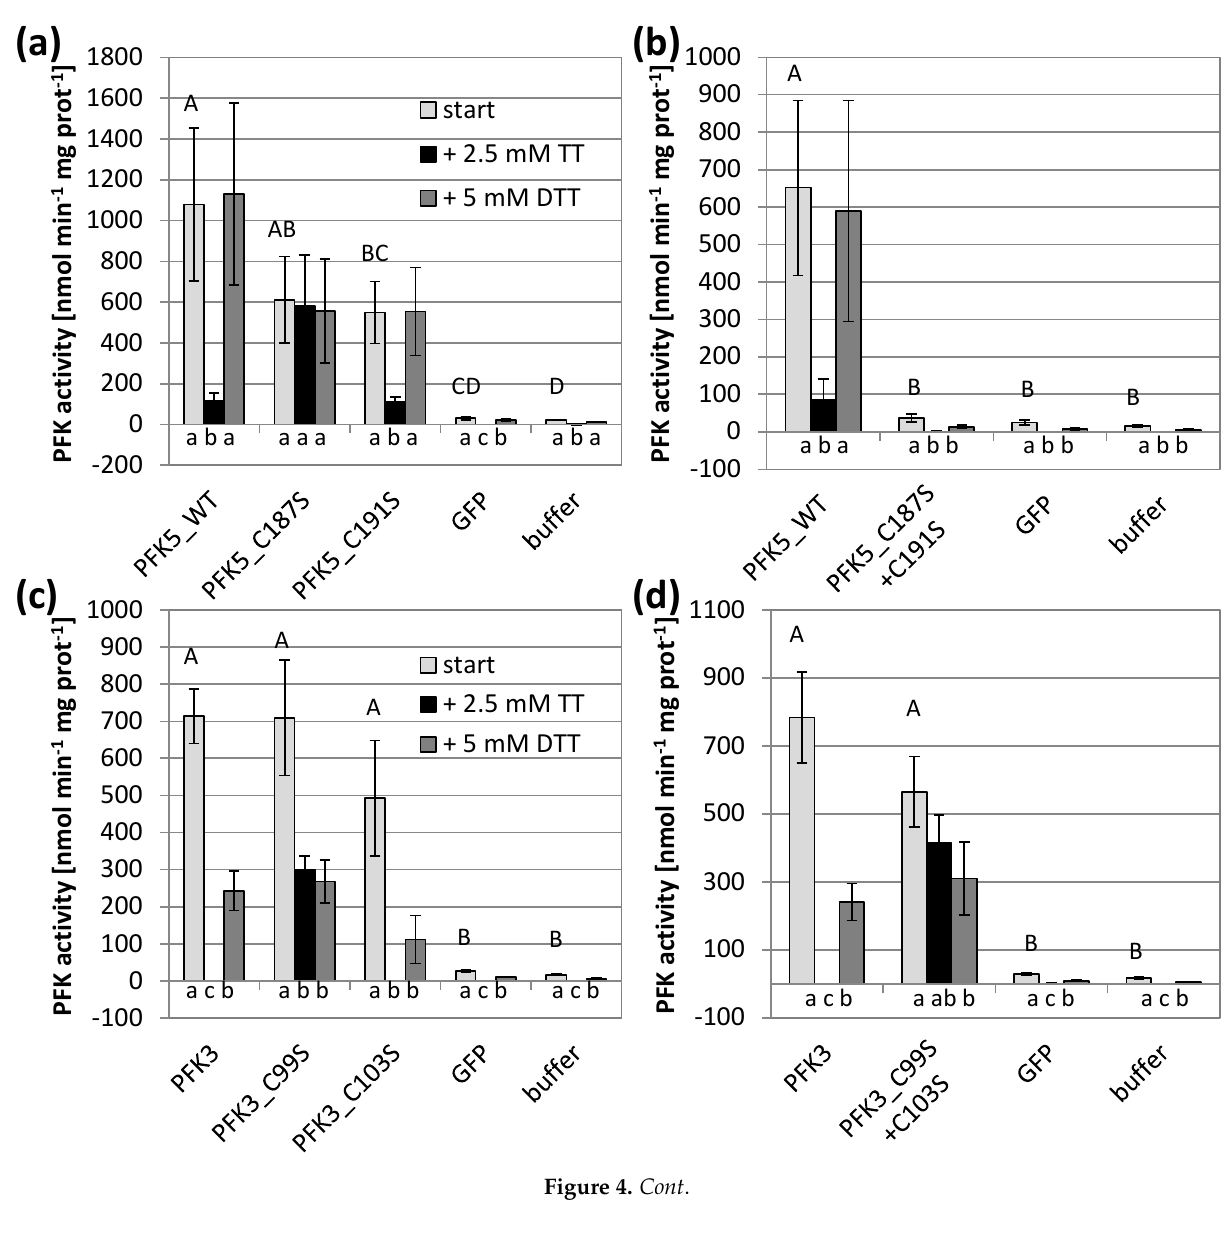
Figure 4. Impact of the CGG(L/I)C motif on PFK activity and oxidation sensitivity. Cys to serine single and double muta- tions were introduced in the CGG(L/I)C motif of A. thaliana AtPFK3 and AtPFK5 proteins. The variants were transiently overex- pressed in tobacco leaves ( a – d ). Wildtype PFK from T. brucei ( f ) as well as PFKs from the tobacco leaf samples ( a – d ) were ex- tracted with buffer containing 5 mM β -mercaptoethanol ( β -ME). After initial activity determination, samples were oxidized with 2.5 mM sodium tetrathionate (TT) for 20 min, and afterwards re-reduced with 5 mM dithiothreitol (DTT). Upper case letters indicate significant differences for each isoform to buffer and GFP control, lower case letters indicate significant differences among treatments for each isoform at p < 0.05 (ANOVA, Post hoc Tukey test, n = 3–6). The results are means ± SD. ( e ) Detail of the protein alignment of the CGG(L/I)C motif in PFKs from A. thaliana , O. sativa and T. brucei . The two mutated Cys are marked with an